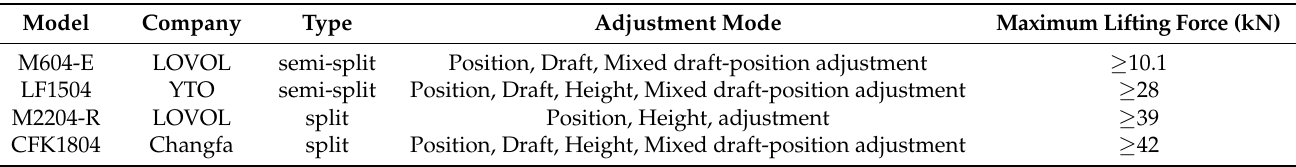
Table 2. Types and Technical Characteristics of Hydraulic Suspension Systems in